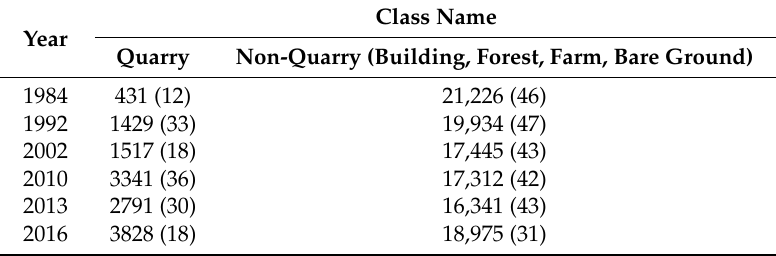
Table 1. Classification scheme with the number of training samples (number of sample pixels and sample areas in six selected